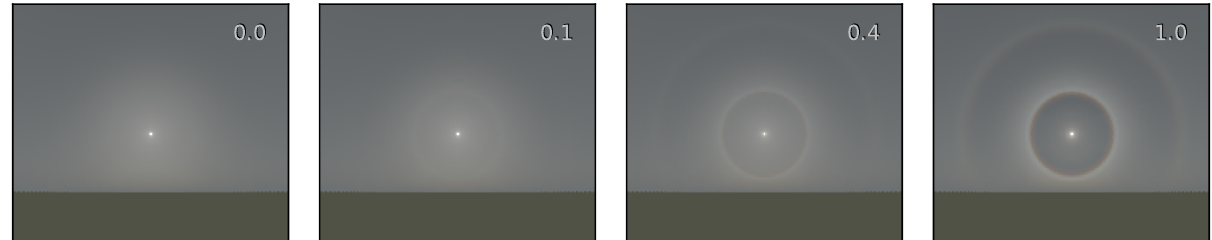
Figure 10. Sky radiance simulations with libRadtran (Mayer and Kylling, 2005) using the DISORT solver for a solar zenith angle of 60 ◦ , a viewing azimuth angle range of 0–160 ◦ and for viewing zenith angles from 10–110 ◦ (i.e., from the zenith to 20 ◦ below the horizon). The simulations were performed for a spectral range of 380–780nm (5nm steps), weighted with the spectral sensitivity of the human eye. A homogeneous cirrus cloud layer with optical thickness of 1 was assumed. Solid column ice crystal optical properties of Yang et al. (2013) with an effective radius of 80µm were used. Aerosol scattering was not considered. The four panels show radiative transfer simulations with different fractions of smooth solid columns ranging from 0 to 100%, as indicated by the labels. A background of severely roughened solid columns is assumed, with fractions changing from 100 to 0%,